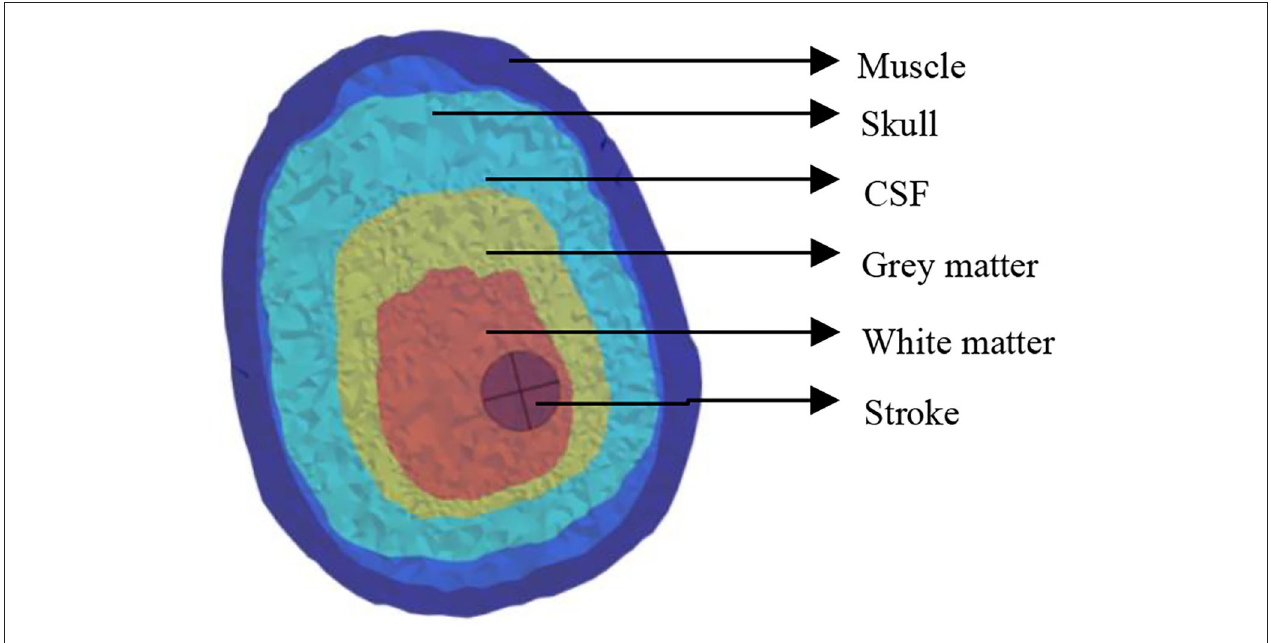
FIGURE 1 | Conductivity of the head’s biological